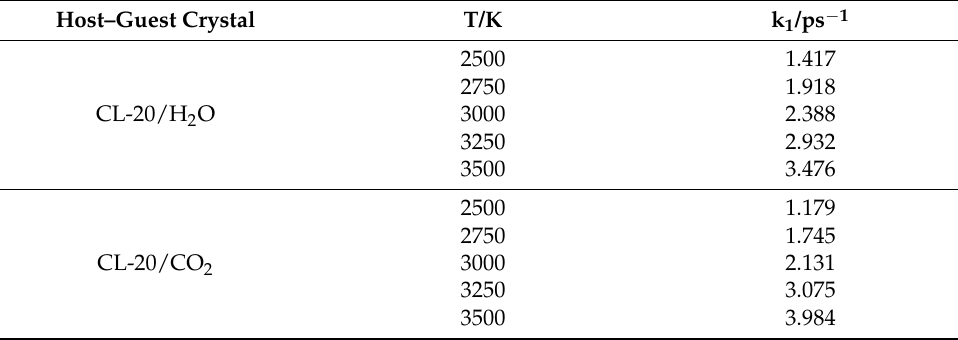
Table 2. Reaction rate constant k 1 in the initial endothermic reaction